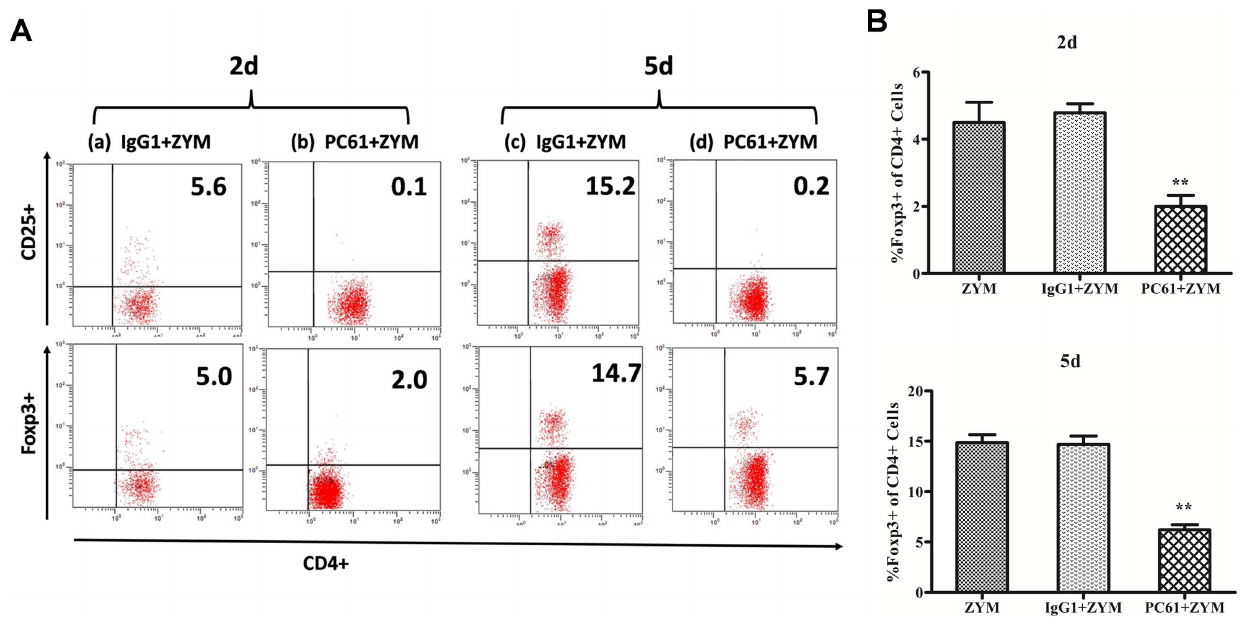
Figure 5. Effect of the injection of PC61 mAb on the Treg cells of ZIGI mice. Mice (6 animals per group) were injected intraperitoneally with 200 m g of IgG1 mAb (a, c) or 200 m g of purified anti-CD25 mAb (PC61) (b, d) on day 2 2. Zymosan was administered intraperitoneally on day 0. The spleen cells were collected on day 2 and day 5. The numbers indicate the percentage of CD4 + CD25 + cells within the CD4 + population and the percentage of Foxp3 + cells within the CD4 + population. The values show the means 6 SEM. ** P , 0.01 compared withthe ZYM and the IgG1 + ZYM groups. doi:10.1371/journal.pone.0064397.g005 inflammation model. The experimental groups in this analysis depleted approximately 50% of the Foxp3 + cells that were present were the following: ZYM, IgG1 + ZYM and PC61 + ZYM. As in the spleen on day 2 (2.02 6 0.32; P , 0.01) and day 5(6.21 6 0.50; P , 0.01) after the injection of zymosan compared with ZYM (day shown in Figure 5, we found that the injection of the PC61 mAb